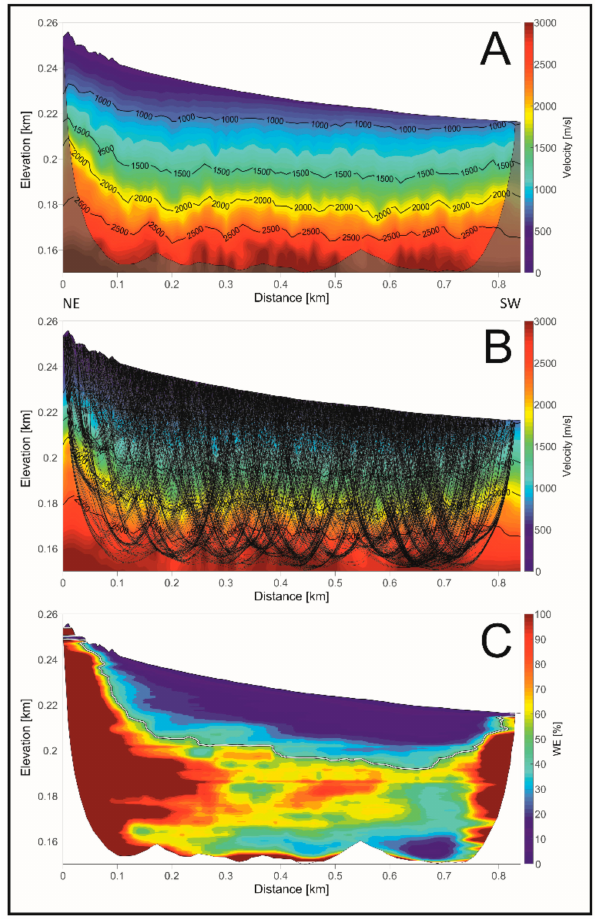
Figure 5. The best result of the first-arrival travel-time tomography (FATT): ( A ) The velocity field. The unconfirmed area without ray coverage was greyed out. The color contour corresponds to the resolved part of the result with high-density ray coverage; ( B ) ray paths; ( C ) the map of uncertainty normalized by the ray coverage – WE (weighted error). The black and white line corresponds to the edge of the area well-resolved by rays (in this particular case, a value of